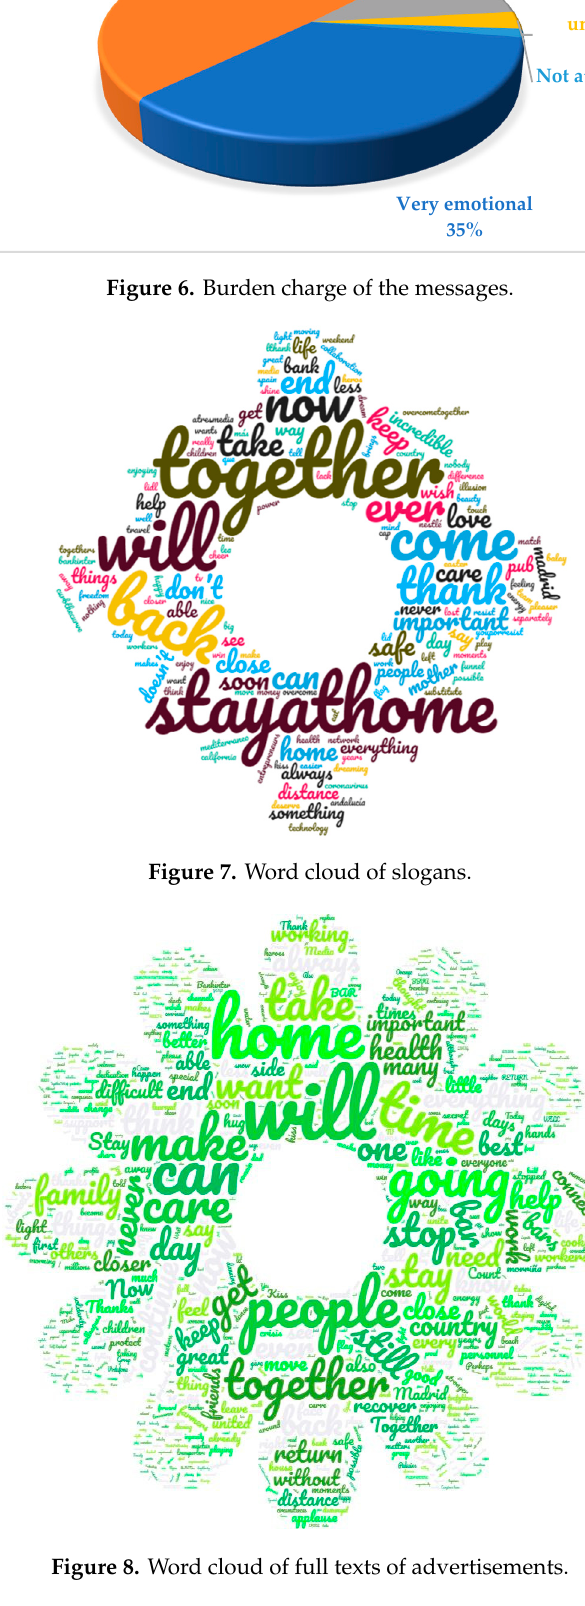
Figure 8. Word cloud of full texts of advertisements.